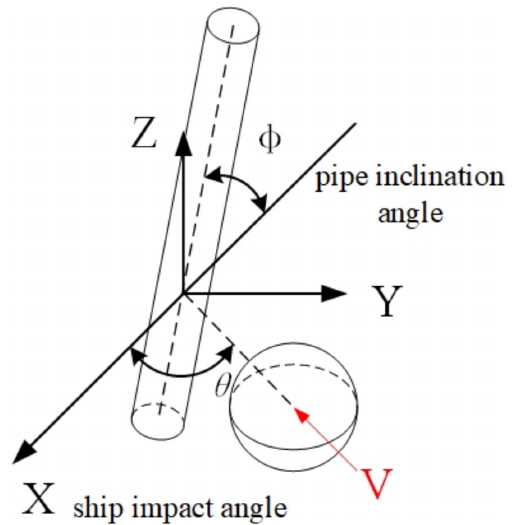
Figure 19. Ship impact angle.